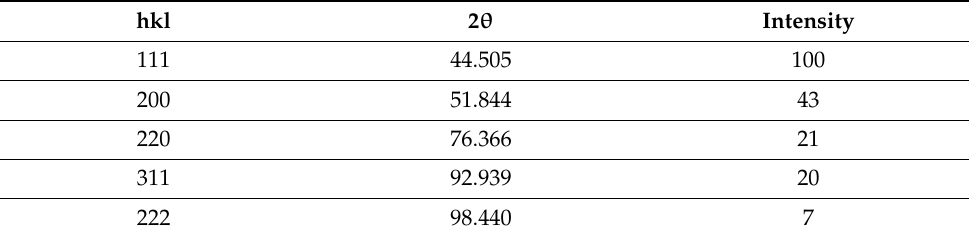
Table 1. Angular values of re fl ections and their intensities.